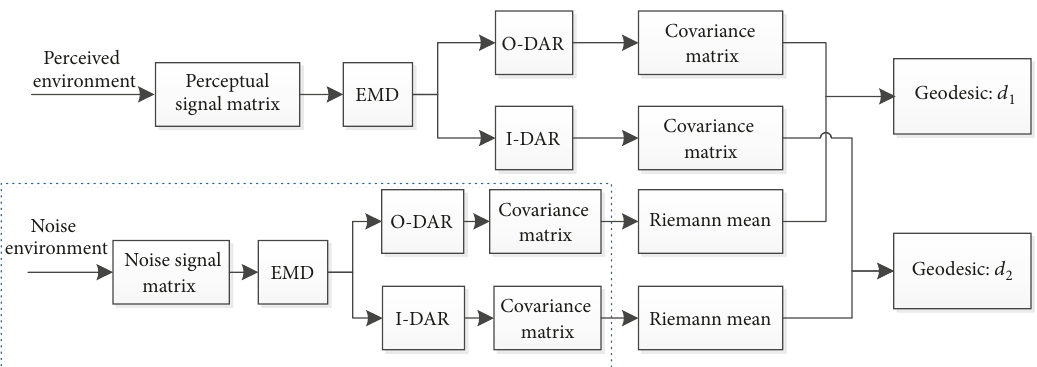
Figure 2: The process of feature extraction based on EMD and information